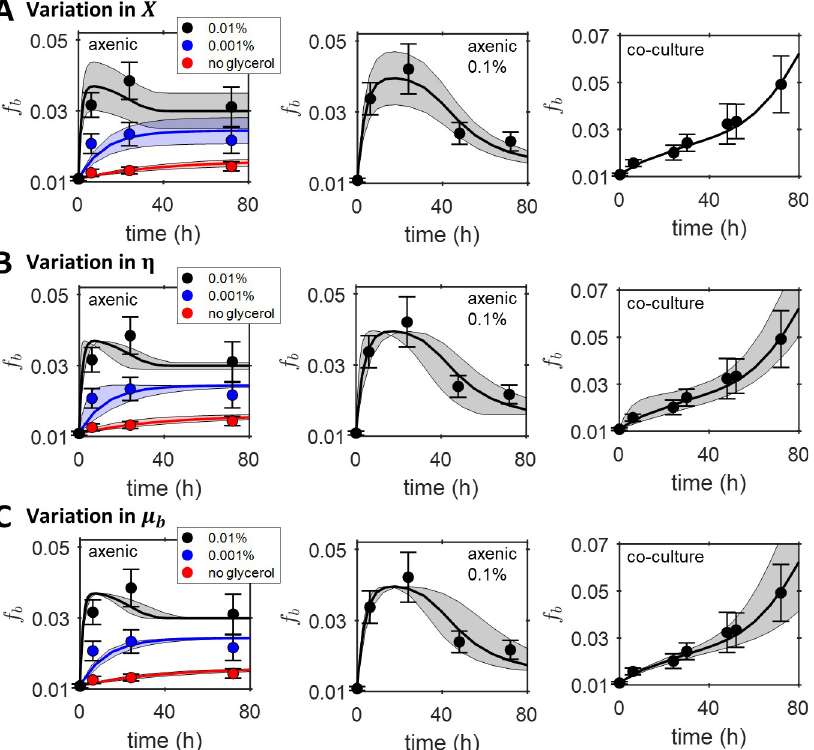
Fig 5. Comparison of single cell heterogeneity predicted by the model and measured experimentally with SIMS. The dilution-corrected results for the mean atomic fraction f b obtained using SIMS (circles with error bars indicating standard deviations of single cell values). Solid lines indicate the model fit results, while shaded regions indicate predicted ranges of f b values, when a range in a specific model parameter is considered. (A) The range of X values considered for 0.1%, 0.01%, 0.001% and no glycerol cultures of axenic bacteria were X 2 [0.034,0.058], X 2 [0.031,0.053], X 2 [0.016,0.028] and X 2 [0.007,0.011] respectively. For the co-culture the range considered was X 2 [0.011,0.019]. (B) The range of η values considered for 0.1%, 0.01%, 0.001% and no glycerol cultures of axenic bacteria were η 2 [0.21,0.81], η 2 [0.05,0.25], η 2 [0.09,0.69] and η 2 [0.33,0.93] respectively. For the co-culture the range considered was η 2 [0.11,0.91]. (C) For axenic cultures of bacteria μ b 2 [0.11,0.19] and for the co-culture μ b 2 [0.34,0.50] in units of h − 1 . Variation in X best accounts for the observed temporal trends in the standard deviations of the single cell data for the axenic cultures, whereas variation in μ b best accounts for the co-culture